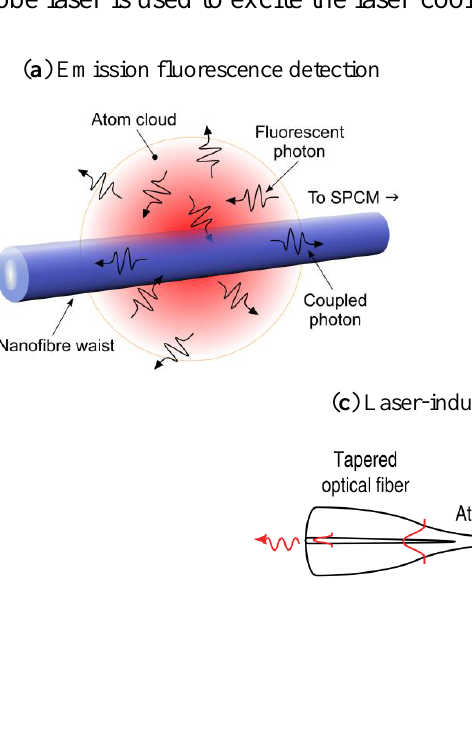
Figure 3. Three techniques to detect neutral atoms using ONFs. ( a ) Emission fluorescence detection; ( b ) Absorption detection. Reprinted with permission from [57]. Copyright 2007 American Physical Society; ( c ) Laser induced fluorescence detection. Reprinted with permission from [58]. Copyright 2008 Institute of Physics. Note that in (c) an additional probe laser is used to excite the laser-cooled atoms, compared to the setup in